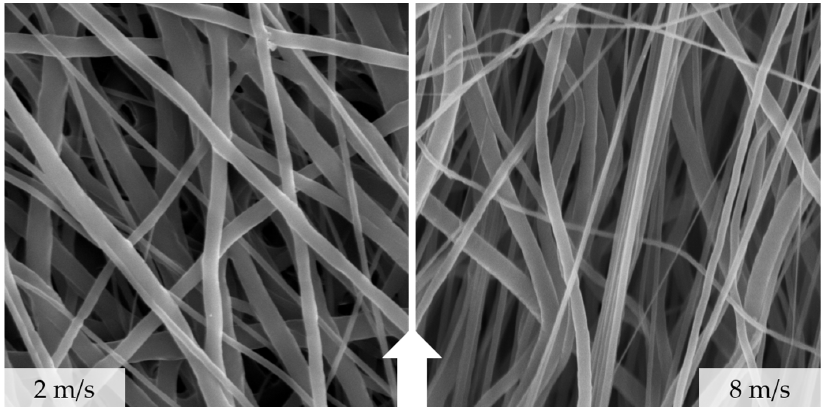
Figure 6. Alignment of fibers according to the relative collector velocity of 2 m/s ( left ) vs. 8 m/s ( right ); the white arrow indicates the rotational direction.